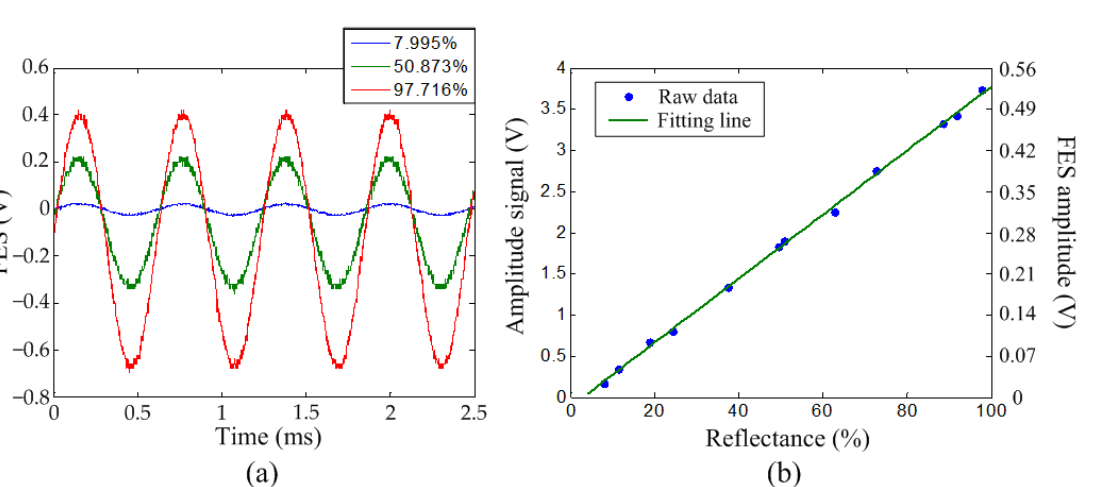
Figure 4. ( a ) FES vs. time and ( b ) relationship between the amplitude signal and reflectance for optical filters with different reflectances.